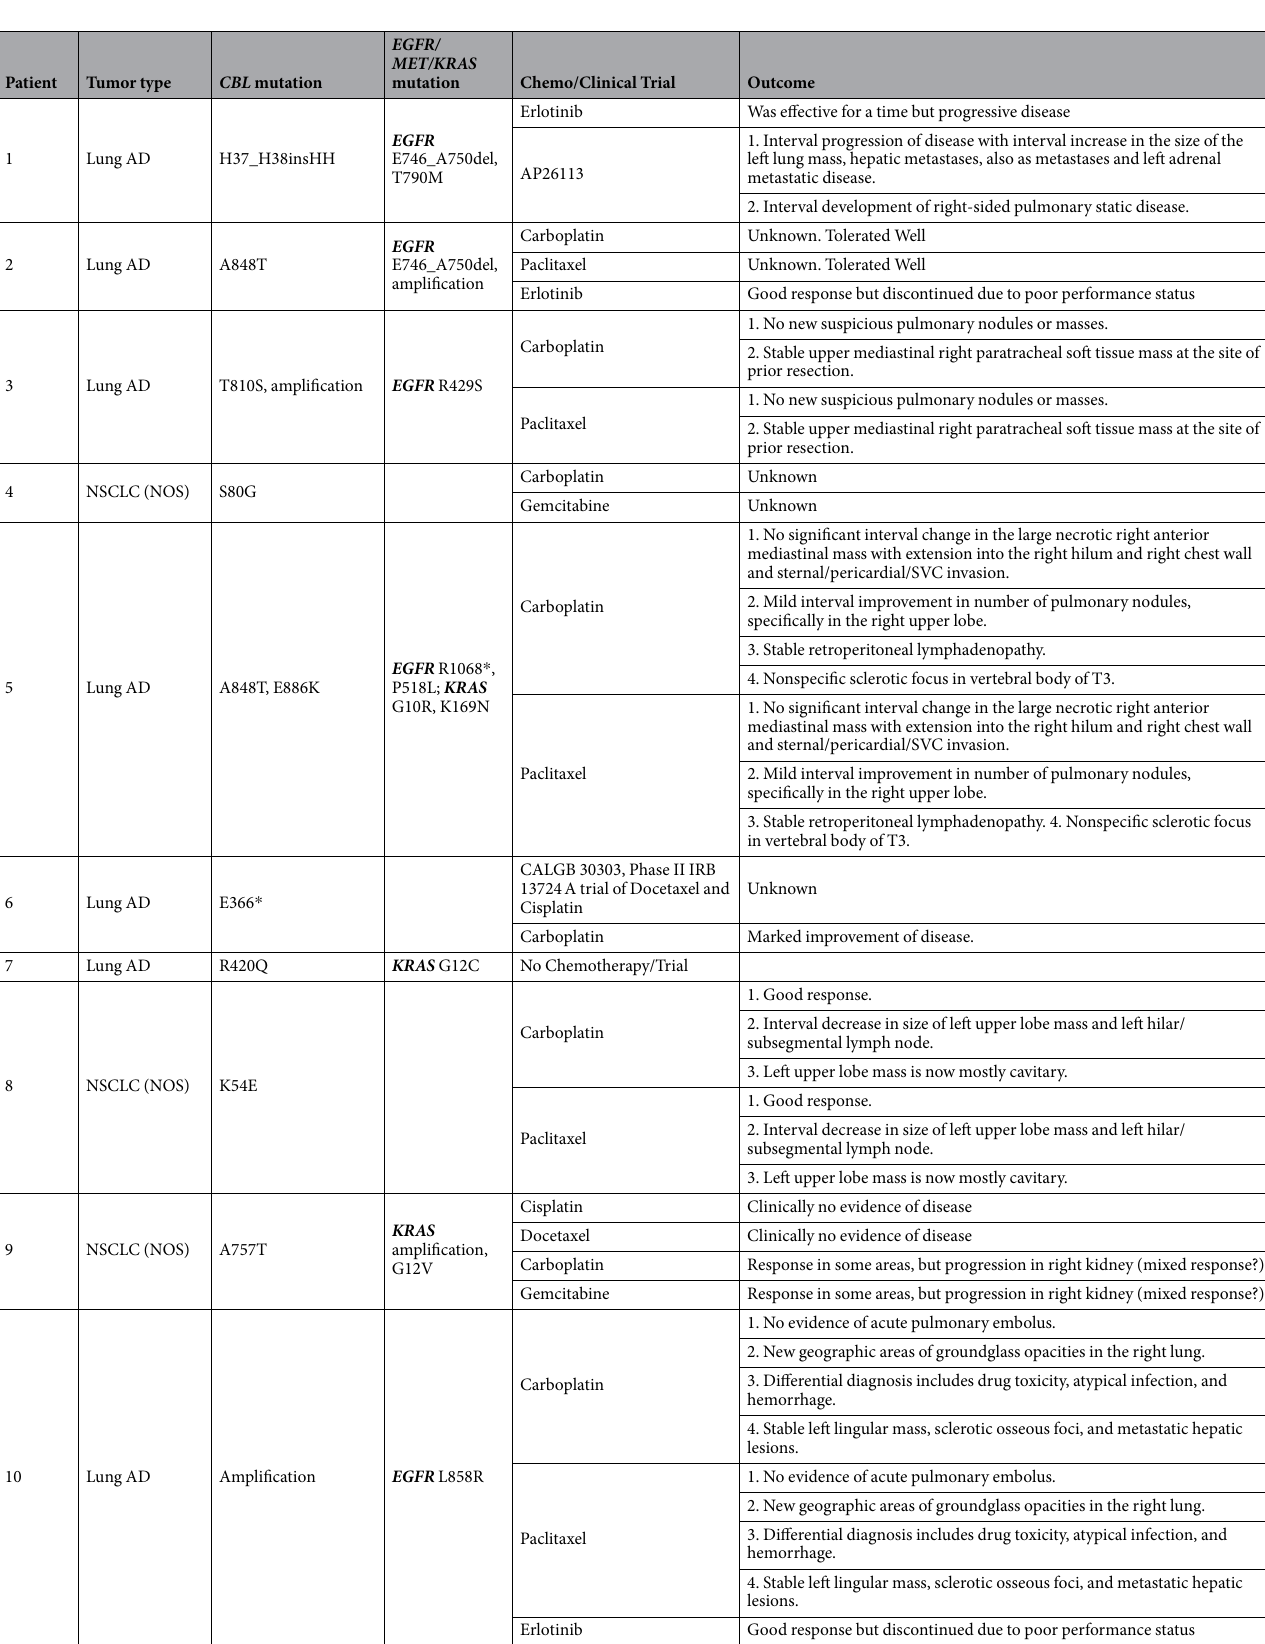
Table 2. Foundation ONE reports of CBL alterations with EGFR, MET, or KRAS alterations and patient treatment outcome. AD: adenocarcinoma; NOS: not otherwise